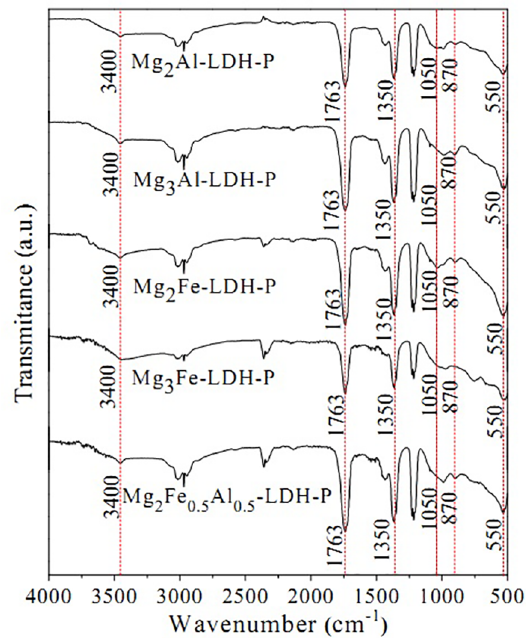
Figure 4. FTIR-ATR spectra of LDHs after anionic exchange reaction: